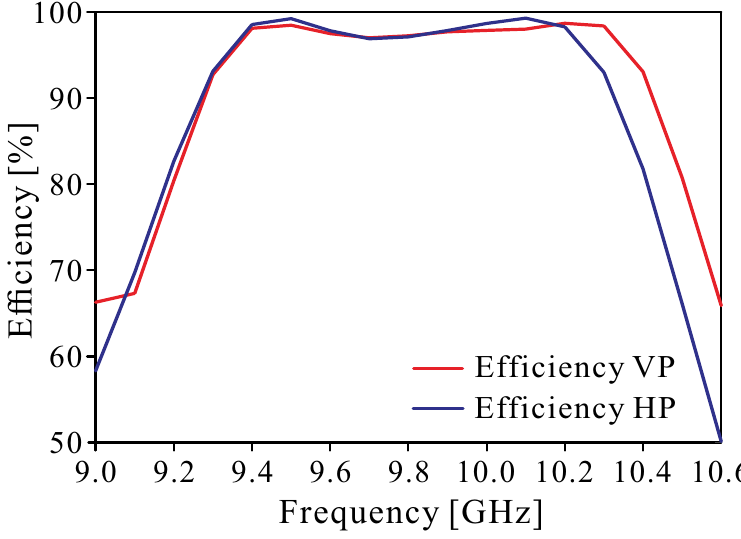
Figure 13. The simulated efficiency of the dual-polarized antenna